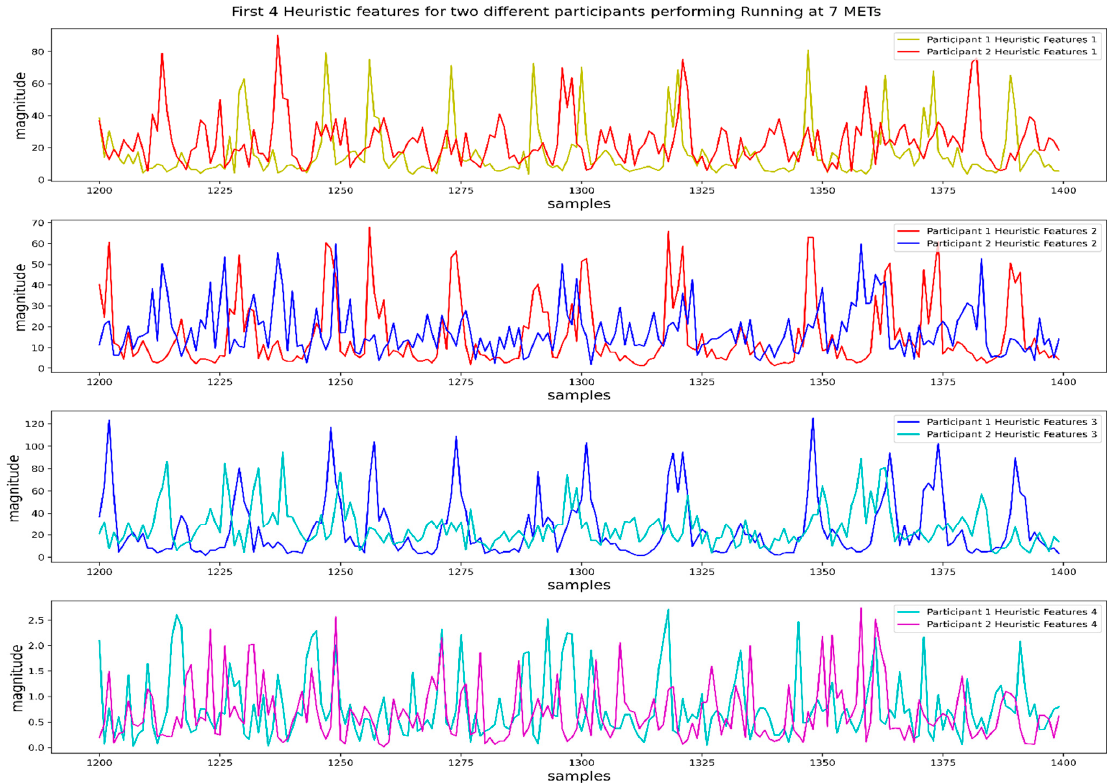
Figure 4. Values of the first four heuristic features for activity running at 7 METs from two different participants.